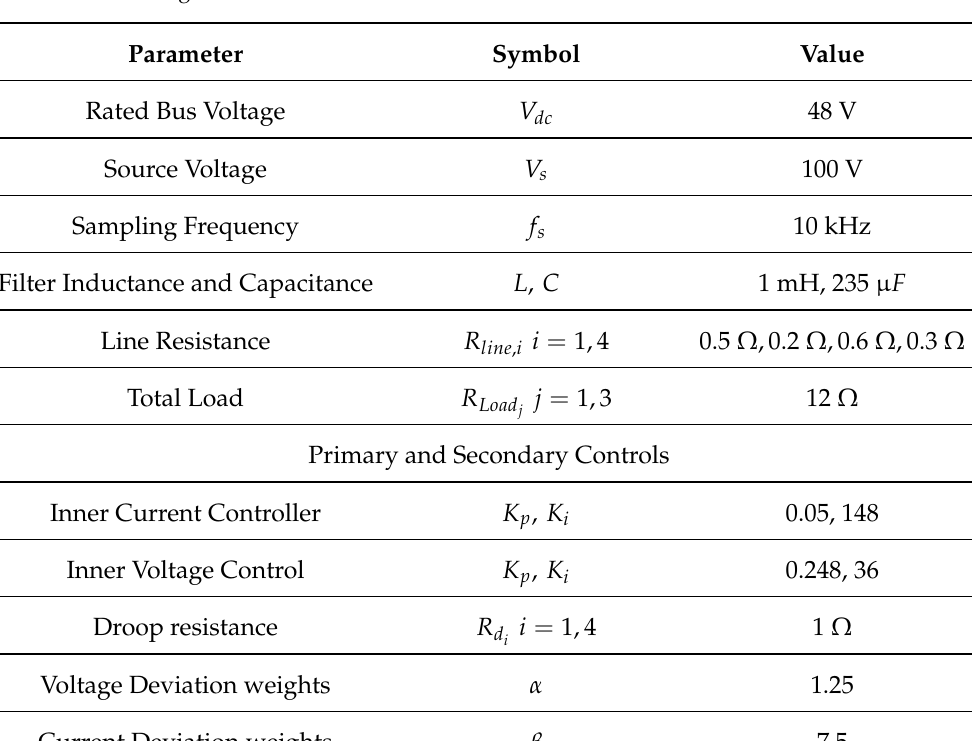
Table 2. DC microgrid